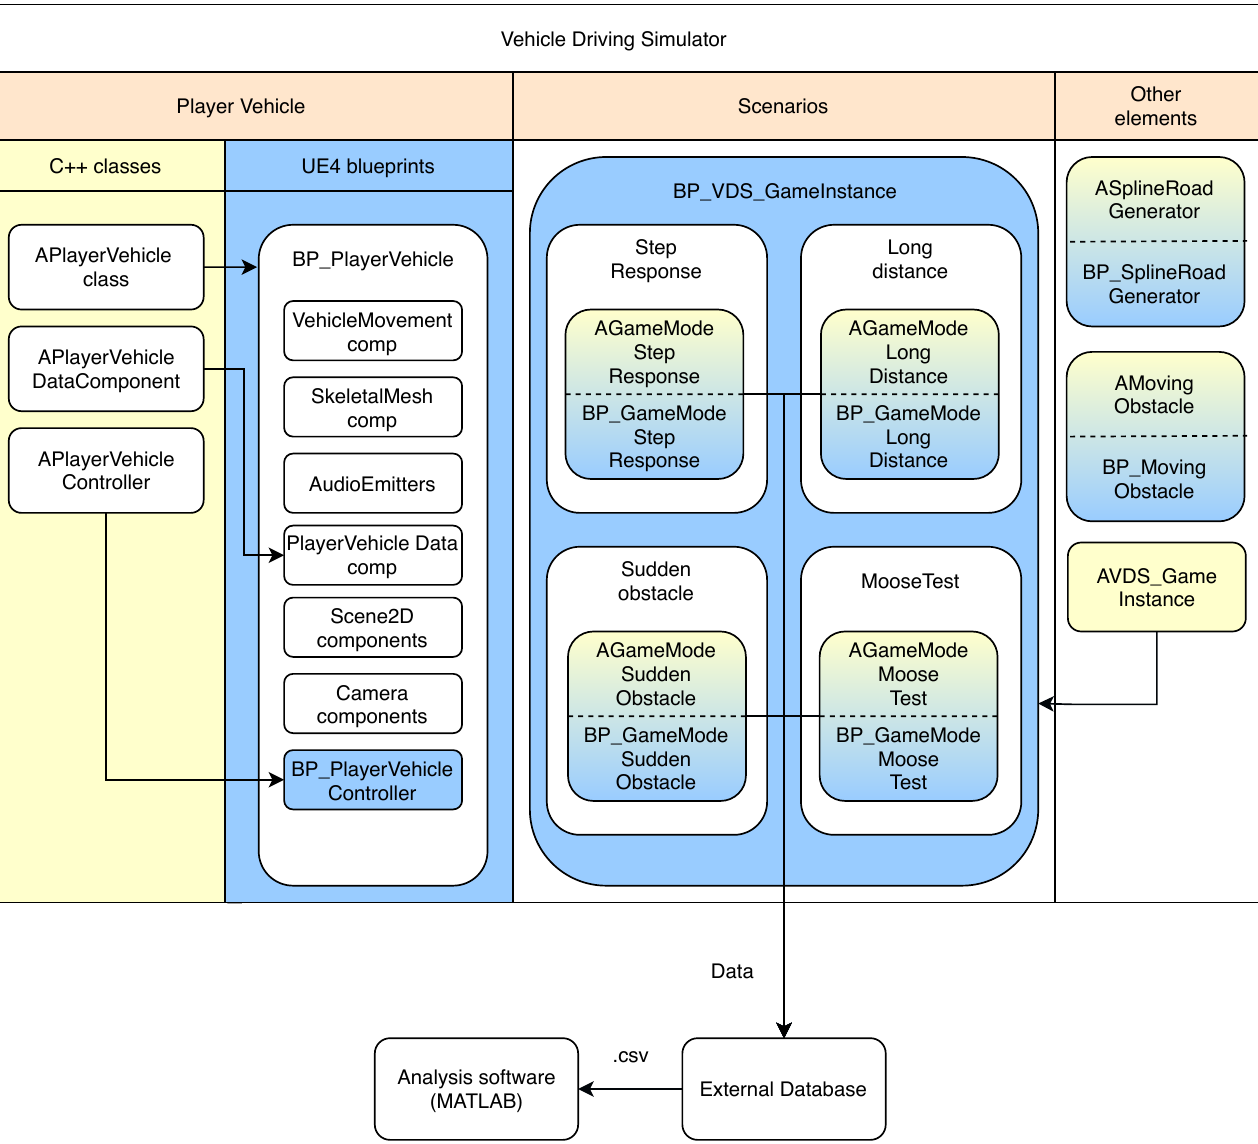
Figure 2. A diagram of the Vehicle Driving Simulator